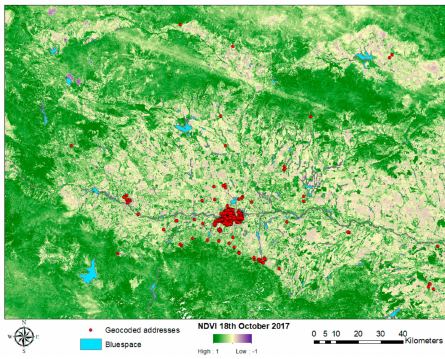
Figure 2. Map of residential addresses superimposed over Normalized Difference Vegetation Index (NDVI) geographic